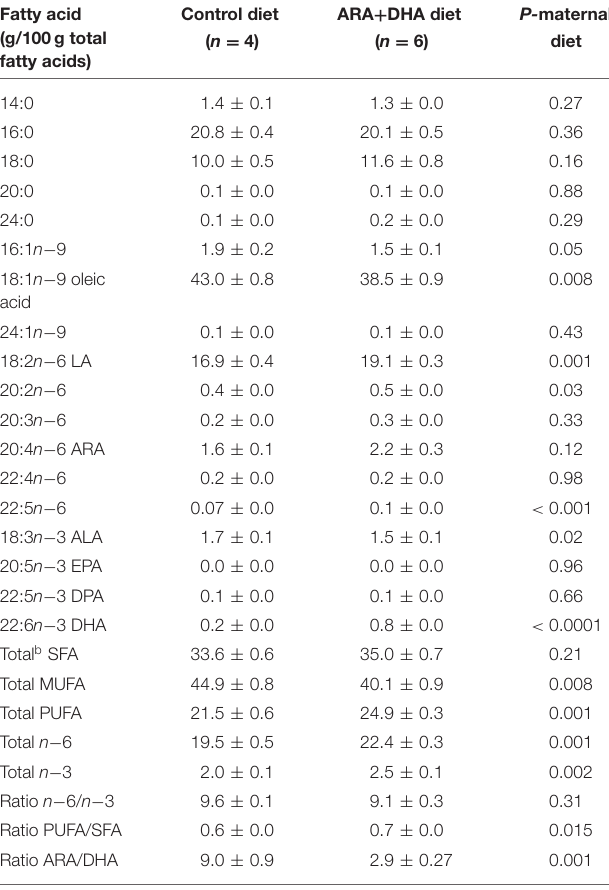
TABLE 2 | Fatty acid composition of total lipids in breastmilk from the mammary gland of Brown Norway dams at the end of suckling period a . Fatty acid Control diet ARA + DHA (g/100g total fatty acids)